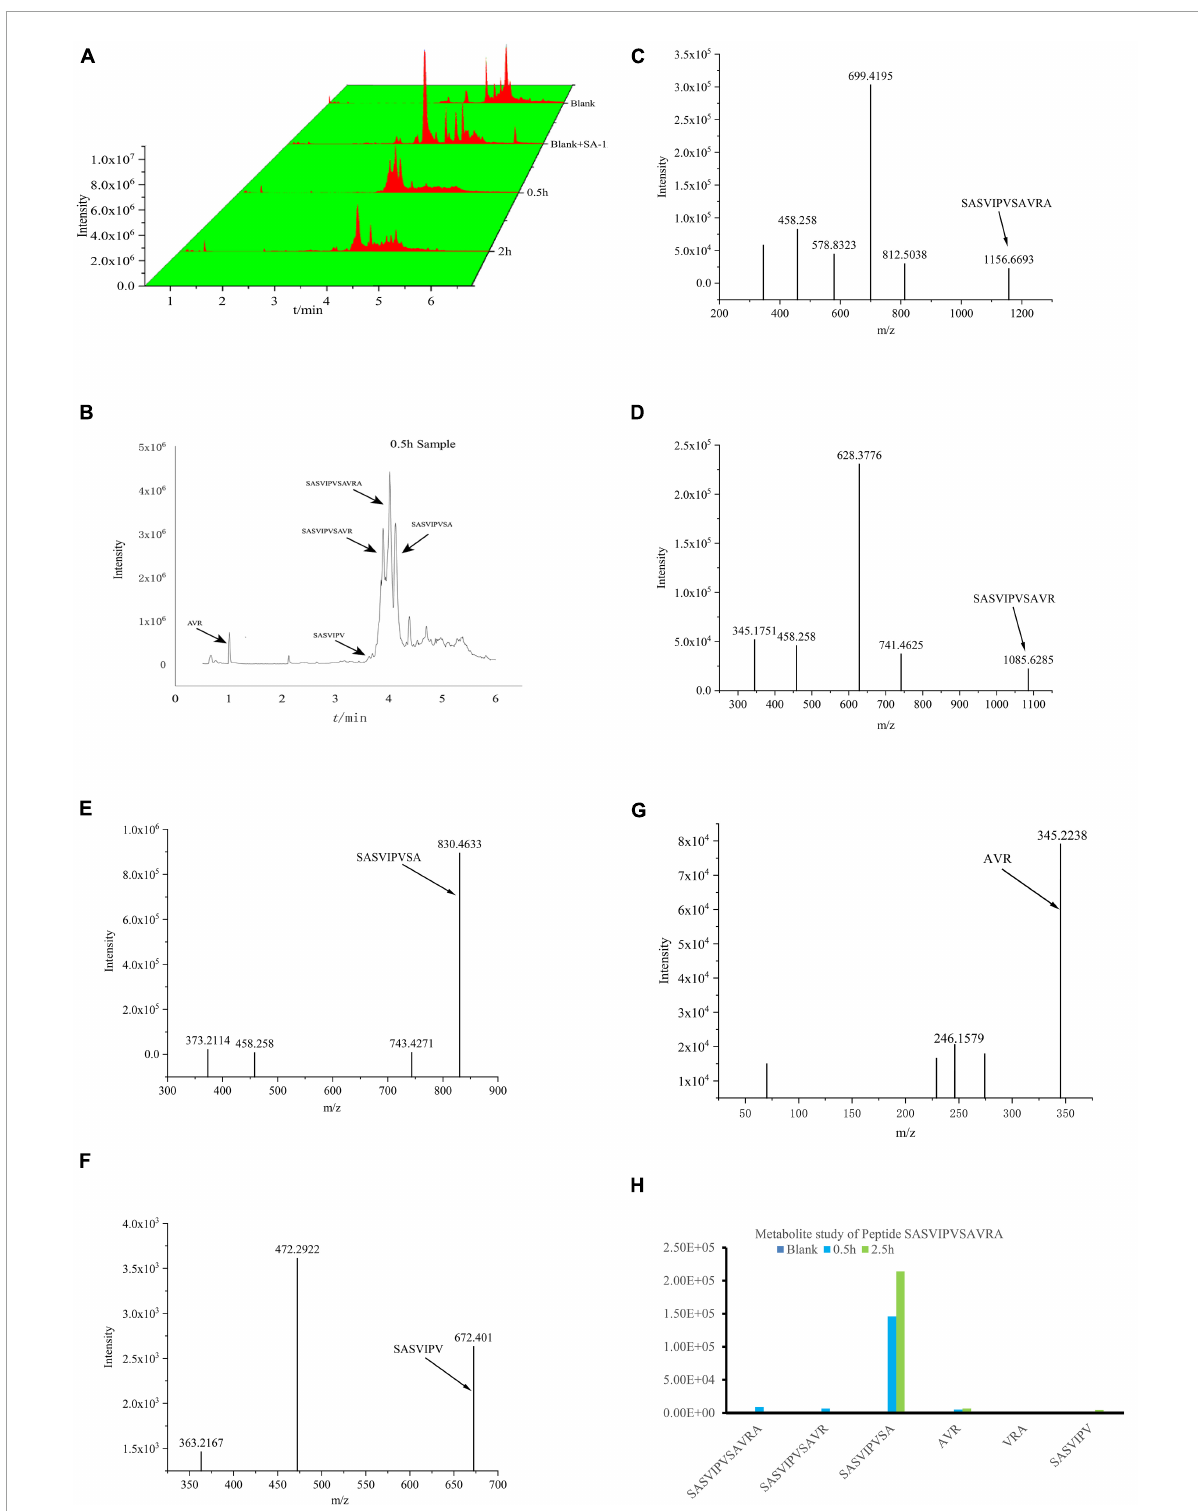
FIGURE3 Analysis of peptides SASVIPVSAVRA after digestion. (A) 3D waterfall Tic chromatography of the samples. (B) Tic chromatography of the 0.5 h samples. (C) Ms spectrum of peptide SASVIPVSAVRA. (D) Ms spectrum of peptide SASVIPVSAVR. (E) Ms spectrum of peptide SASVIPVSA. (F) Ms spectrum of peptide SASVIPV. (G) Ms spectrum of peptide AVR. (H) Peak area of Metabolites in digestion